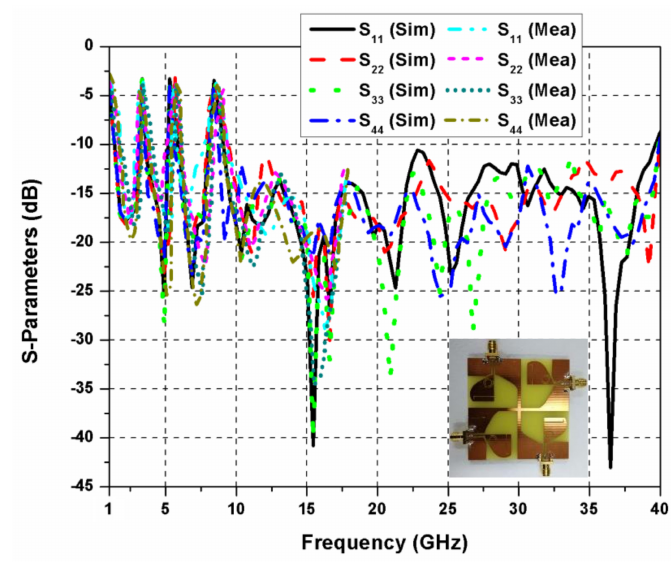
Figure 7. Reflection coe ffi cients of the proposed quad-port super-wideband (SWB) MIMO antenna.